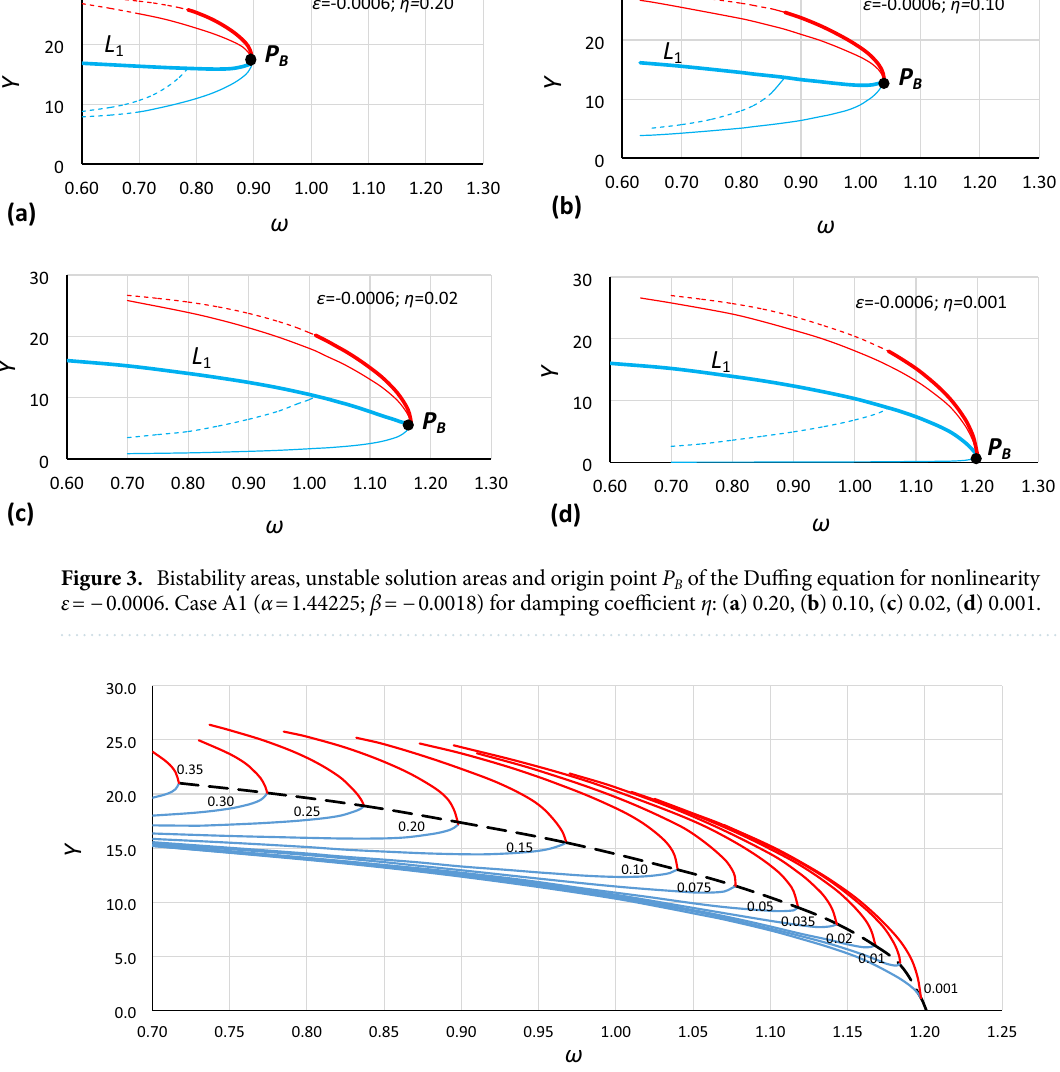
Figure 4. Curve of the origin point P B for case A1 ( α = 1.44225, β = − 0.0018, ε = − 0.0006) determined as a curve of convergence points of line L 1 (blue lines) and the upper limit of the bistability area for resonant oscillations (red lines), calculated for different values of damping coefficient η (from 0.001 to